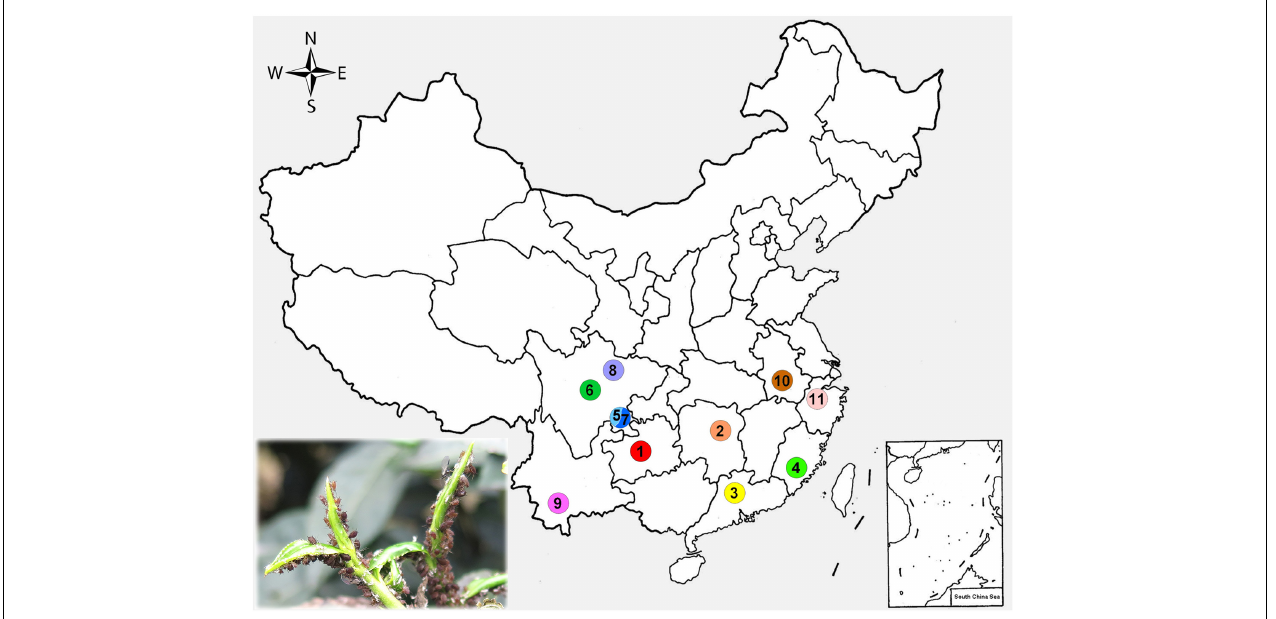
FIGURE 1 | Collection localities of the samples used in this study. (1) Guiyang, Guizhou Province; (2) Changsha, Hunan Province; (3) Qingyuan, Guangdong Province; (4) Quanzhou, Fujian Province; (5) Dadukou, Sichuan Province; (6) Ya’an, Sichuan Province; (7) Huguo, Sichuan Province; (8) Mianyang, Sichuan Province; (9) Pu’er, Yunnan Province; (10) Chizhou, Anhui Province; (11) Hangzhou, Zhejiang Province.